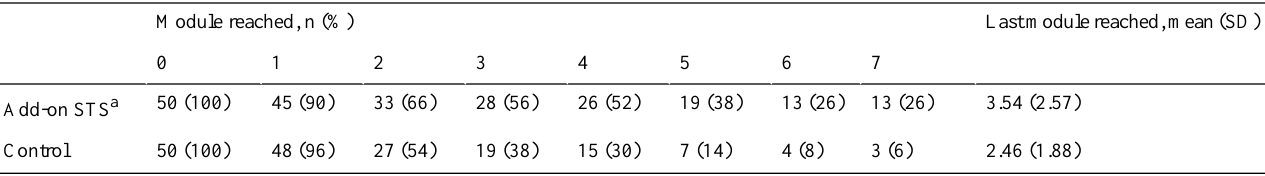
Table 3. Module reached by patients in each group during 6